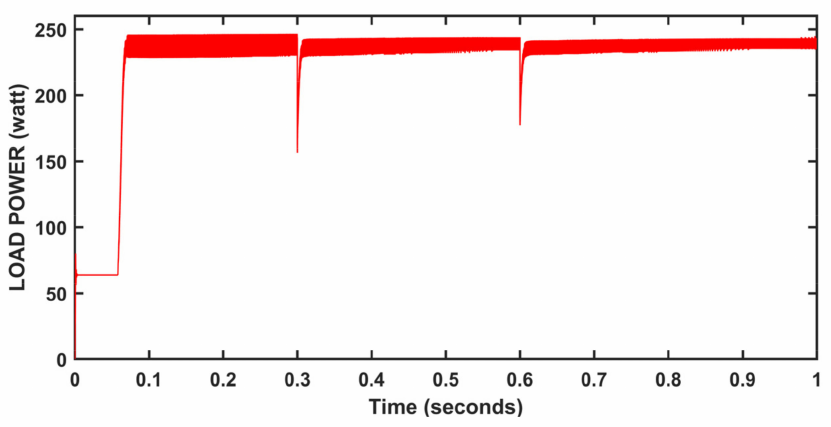
Figure 33. Performance at variable loads and constant irradiation and